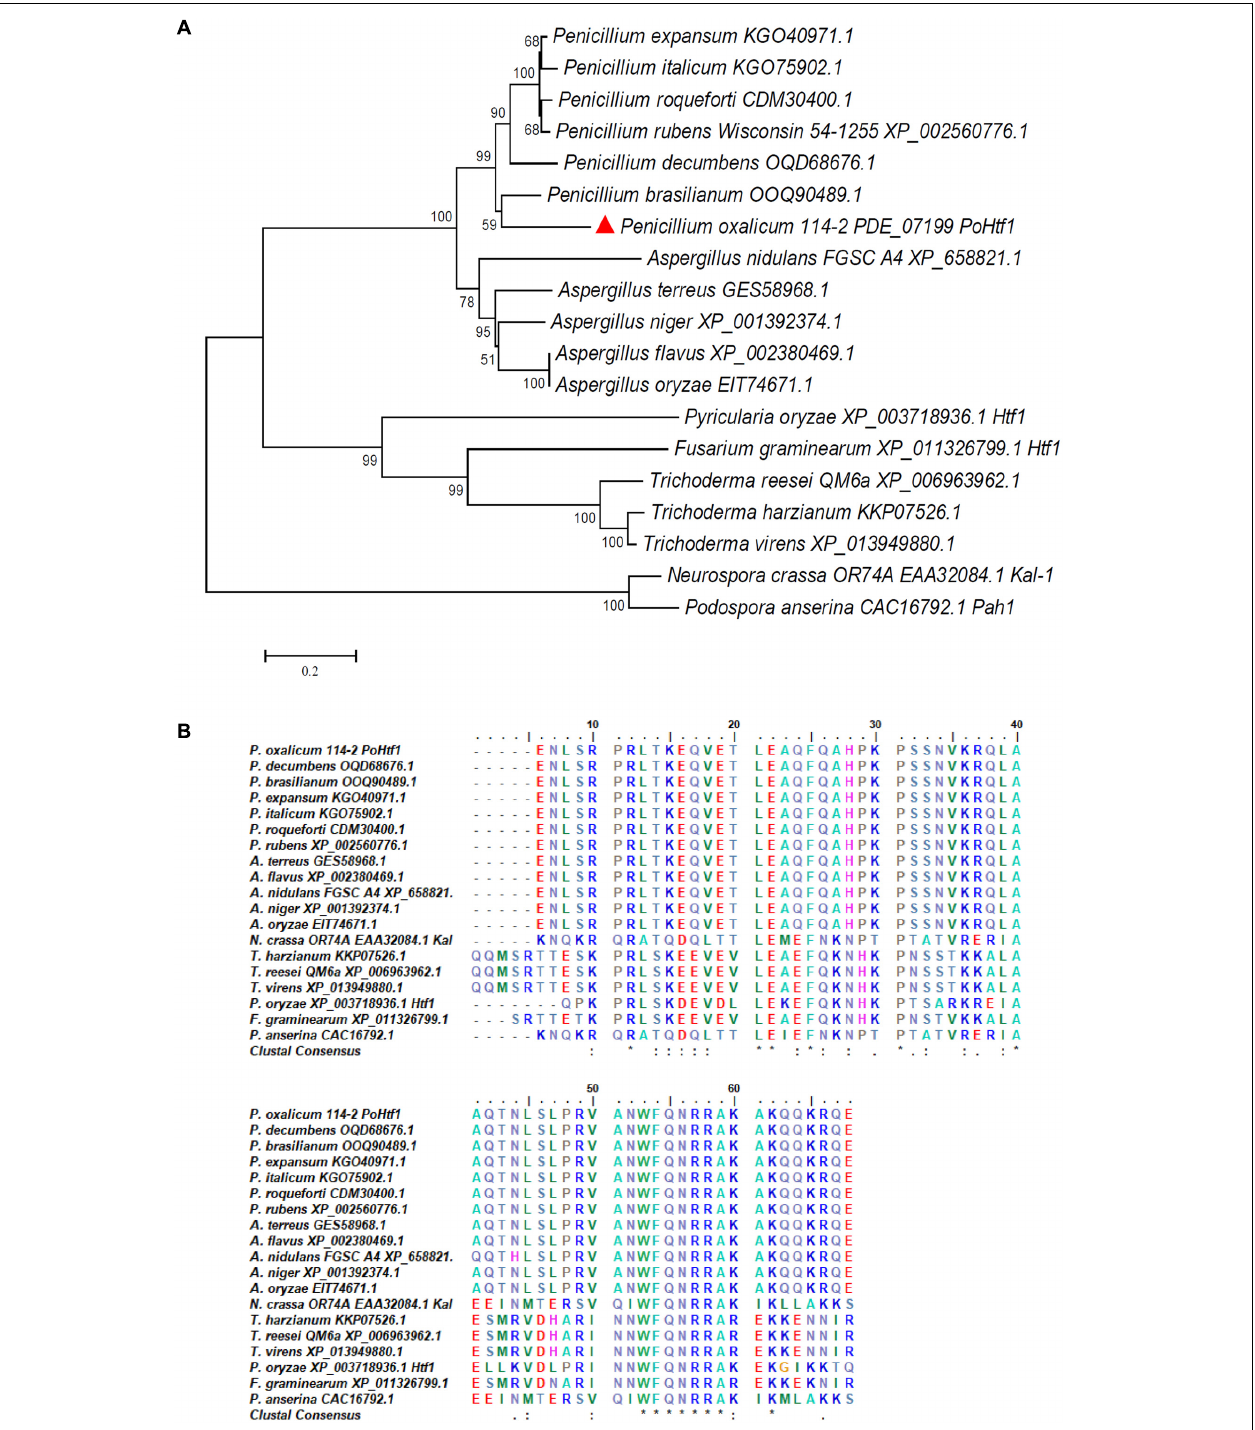
FIGURE 1 | Analysis of the complete and homeodomain sequences of Htfs homologs. (A) Phylogenetic analysis of Po Htf1 homologs. The complete sequences of Htfs from Penicillium sp., Aspergillus sp., Trichoderma sp., Neurospora crassa, Fusarium graminearum, Pyricularia oryzae , and Podospora anserina were downloaded from NCBI. The phylogenetic tree was generated by MEGA 5.0 software using the neighbor-joining (NJ) method. (B) Sequence alignment of the Htfs homolog homeodomains. The alignment was performed by ClustalW Multiple Alignment function in the Bioedit tool. The consensus residues are labeled by asterisk